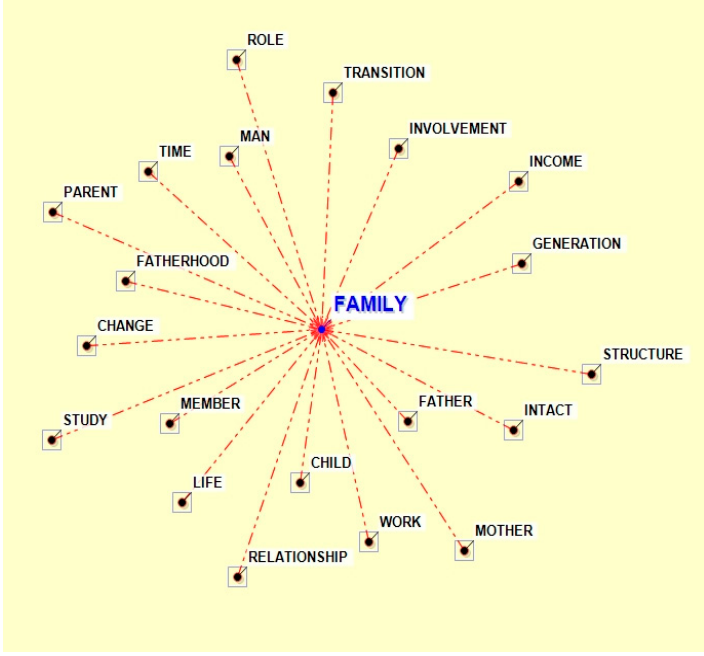
Figure 12. Radial diagram with “family”.